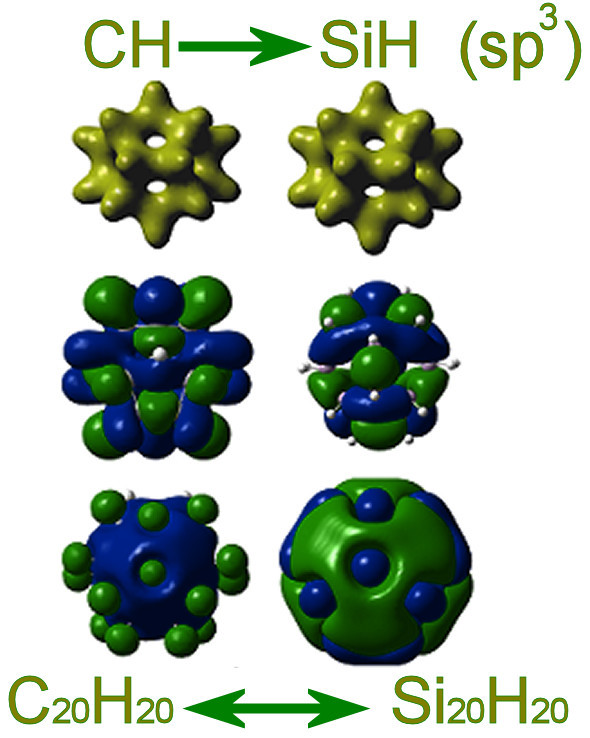
An illustration of the Si and C fullerenes analogy. Comparison and analogy in geometrical and electronic structure of C20H20 and Si20H20 fullerenes.